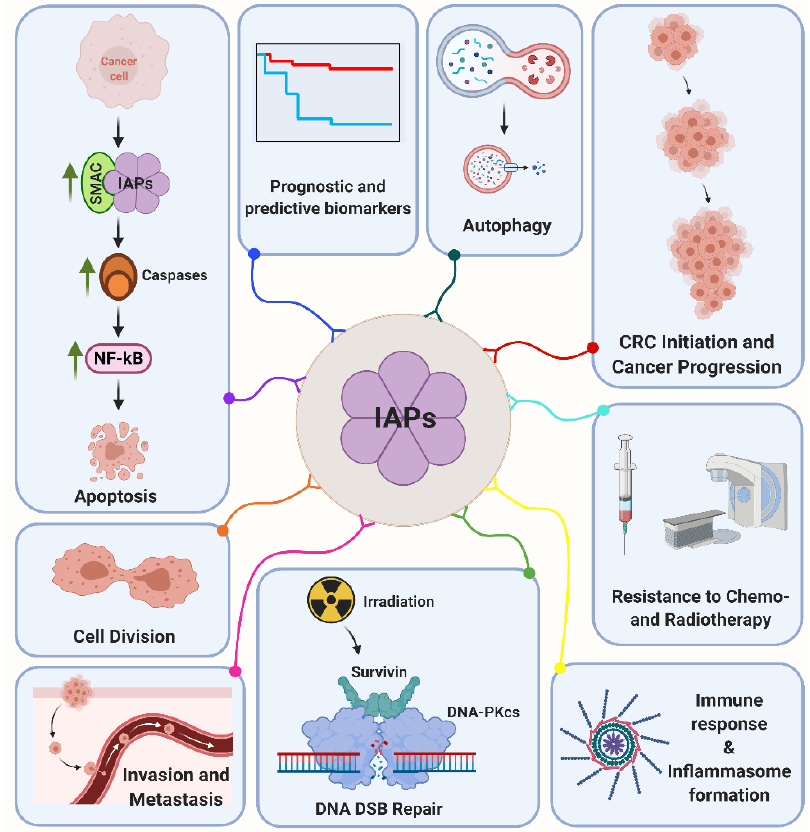
Figure 1. Inhibitor of apoptosis proteins (IAPs) are multifunctional proteins that regulate a variety of key cellular mechanisms such as apoptosis, cell division, invasion and metastasis, autophagy, DNA double-strand break (DSB) repair, cancer progression, immune response and inflammasome formation. Moreover, IAPs are associated with radiation and chemotherapy resistance and are considered to be valuable prognostic and predictive biomarkers in colorectal cancer (CRC). Please see the text for a more detailed discussion. Abbreviations: DNA-PKcs, DNA-dependent protein kinase, catalytic subunit; NF-κB, nuclear factor kappa B; SMAC, second mitochondrial activator of caspases.